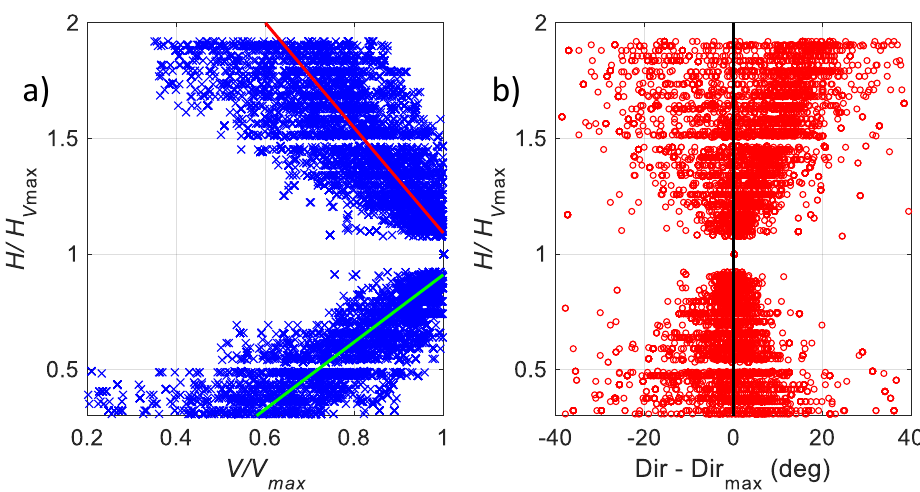
versus the height normalised to H and ( b ) max Vmax